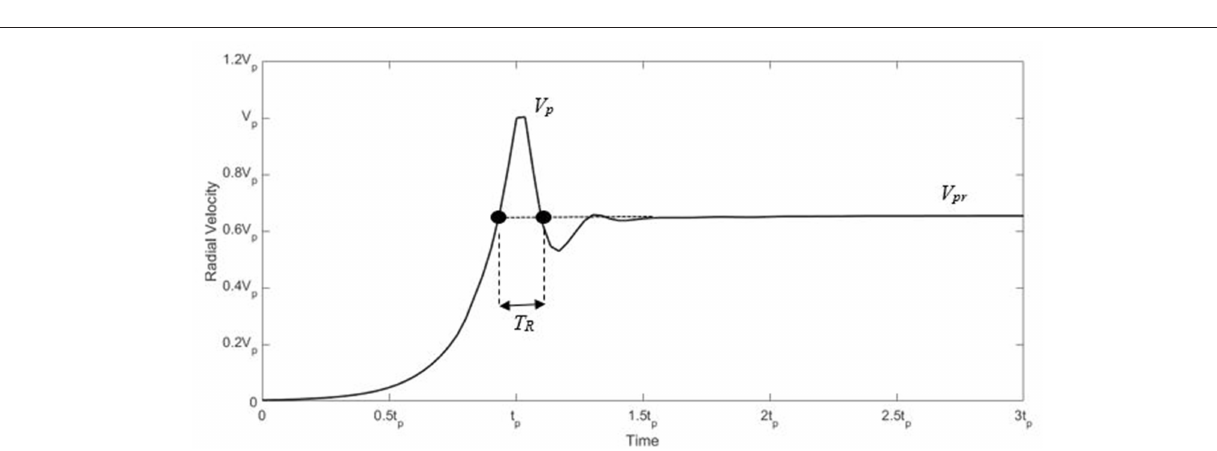
FIGURE 11 | Illustration of the annotations used to characterize the downburst time